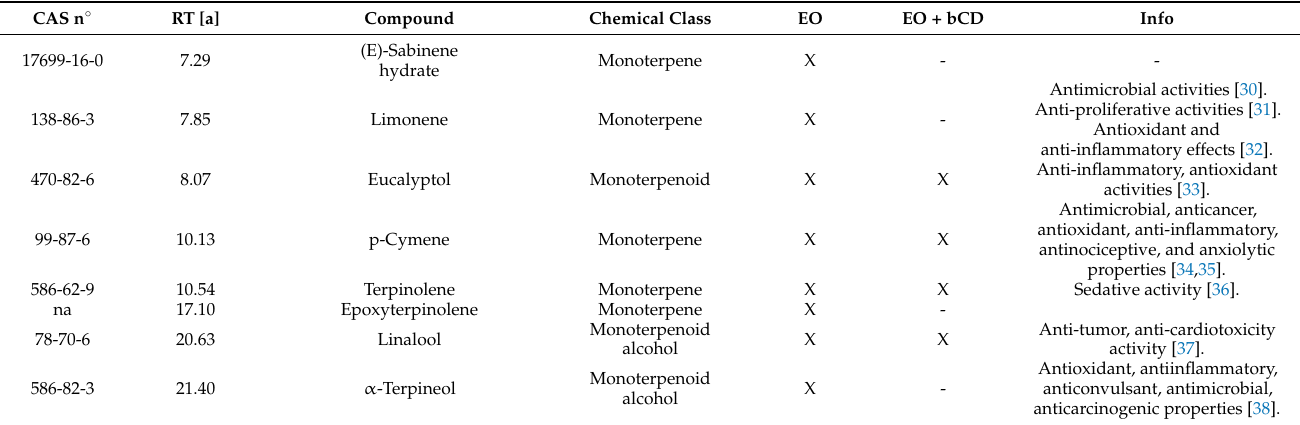
Table 2. Compounds identified by GC-MS method .